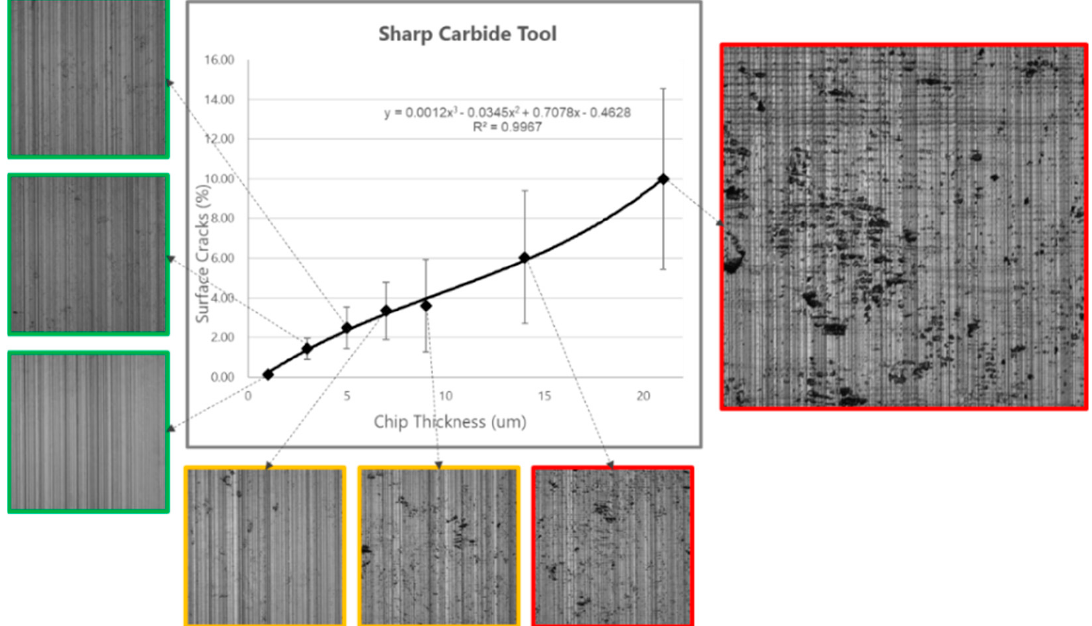
Figure 7. Average surface cracks against chip thickness plot with respective optical images using a sharp carbide tool.